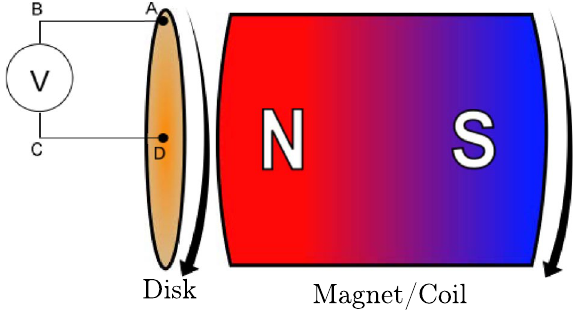
Figure 1. Sketch of a unipolar induction machine (also known as a Faraday